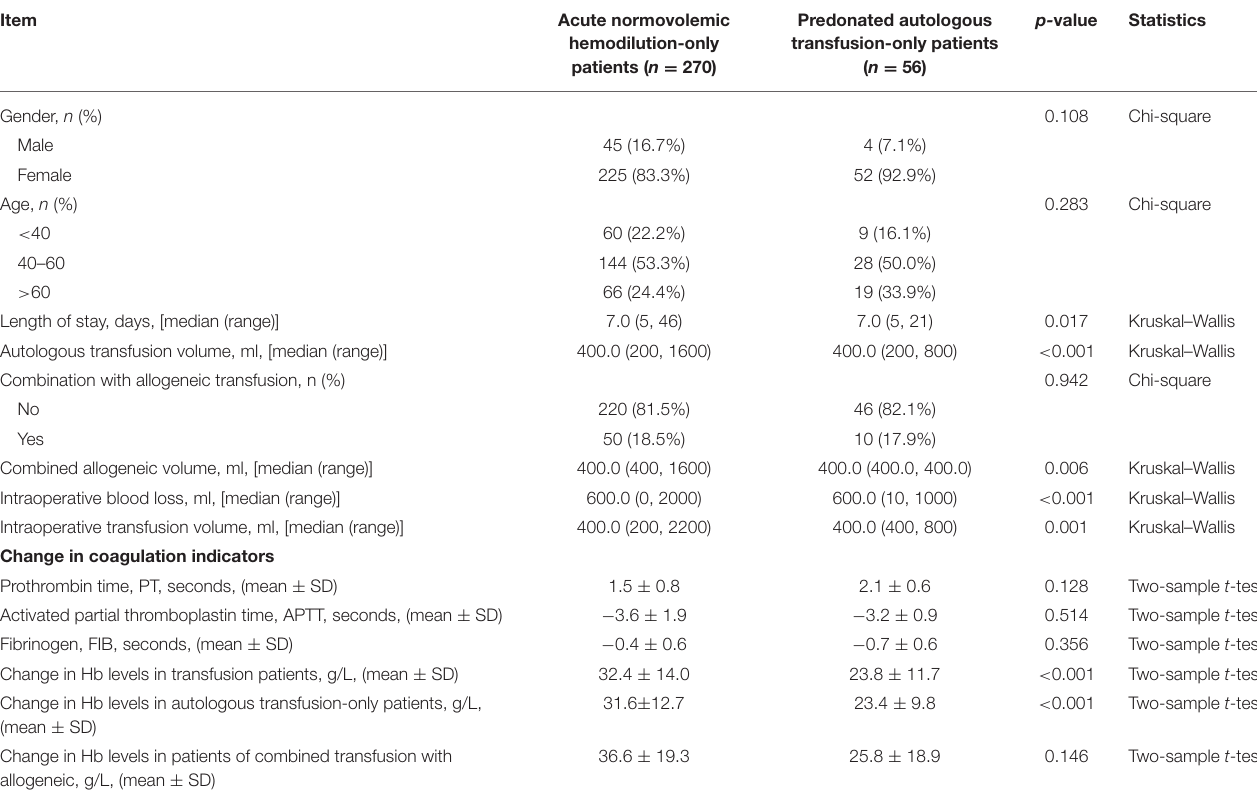
TABLE 3 | Comparison of autologous transfusion mode between acute normovolemic hemodilution-only patients and predonated autologous transfusion-only patients.